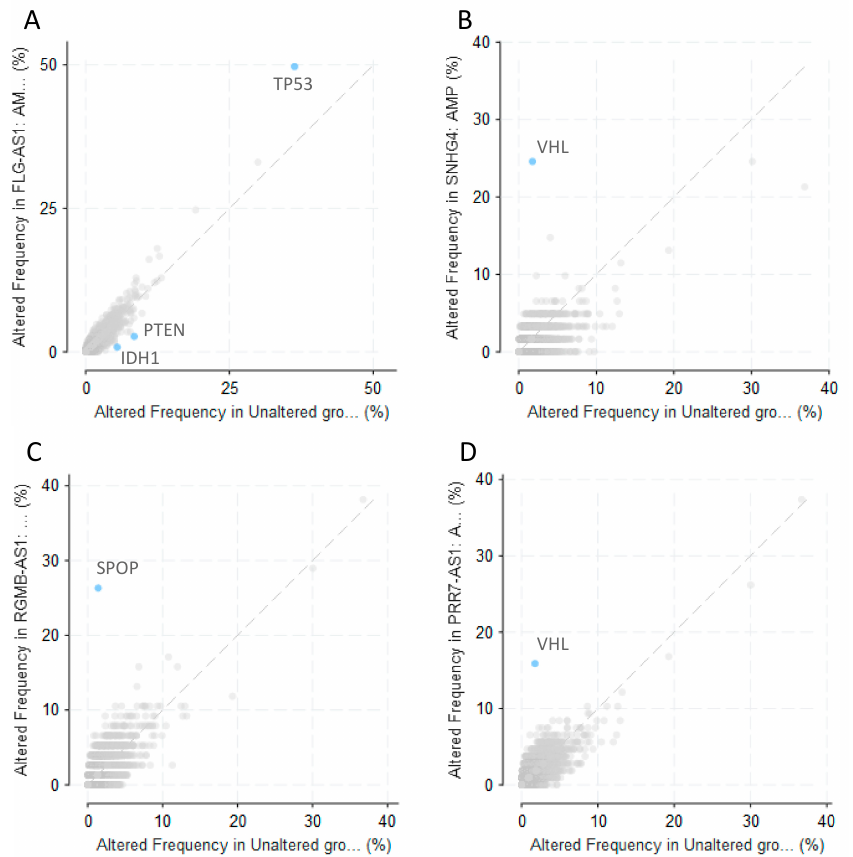
Figure 5. Co-alteration between olaparib-modulated lncRNAs and other genes in cancer. Correlation between alterations in olaparib-modulated lncRNAs and alterations in other genes in samples from the PanCancer Atlas cohort, obtained from cBioPortal. ( A ) Enrichment of amplification in FLG-AS1 in samples with other alterations. Amplification in FLG-AS1 is positively correlated with alterations in TP53 ( q -value = 2.761 × 10 − 3 ) and negatively correlated with alterations in IDH1 ( q -value = 0.0204) and in PTEN ( q -value = 0.0384); ( B ) enrichment of amplification in SHNG4 in samples with other alterations. Amplification in SNHG4 is positively correlated with alterations in VHL ( q -value = 5.98 × 10 − 9 ); ( C ) enrichment of deep deletion in RGMB-AS1 in samples with other alterations. Deep deletion in RGMB-AS1 is positively correlated with alterations in SPOP ( q -value < 10 − 10 ) ( D ); enrichment of amplification in PRR7-AS1 in samples with other alterations. Amplification in PRR7-AS1 is positively correlated with alterations in VHL ( q -value = 2.94 × 10 − 7